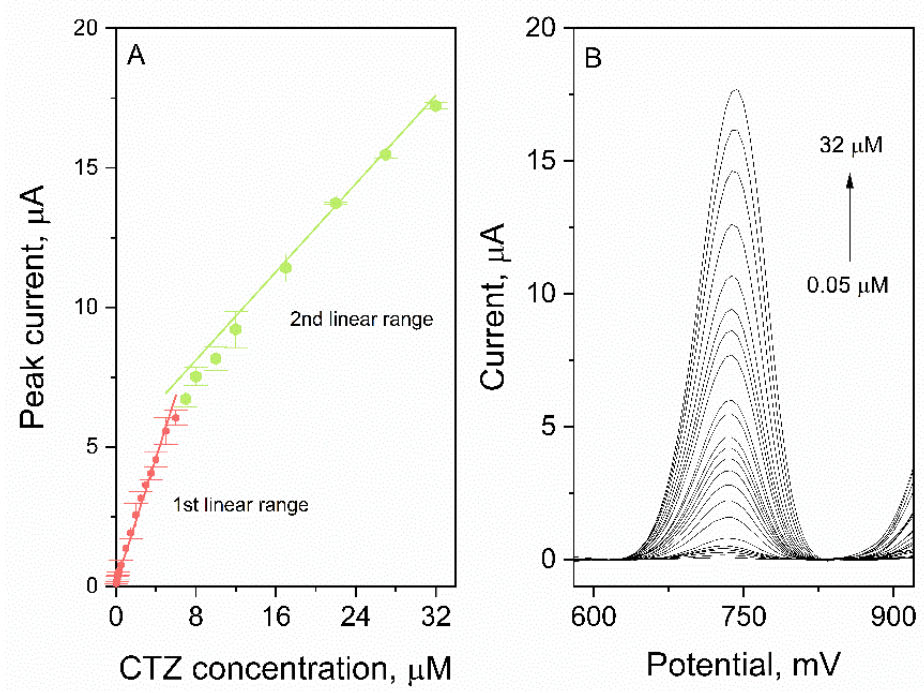
Figure 7. ( A ) CTZ calibrations with 2 linear ranges: 0.05–6 µM; 7–32 µM. ( B ) Voltammograms registered during calibration. Table 1. Comparison of LOD values for CTZ obtained using voltammetric methods.